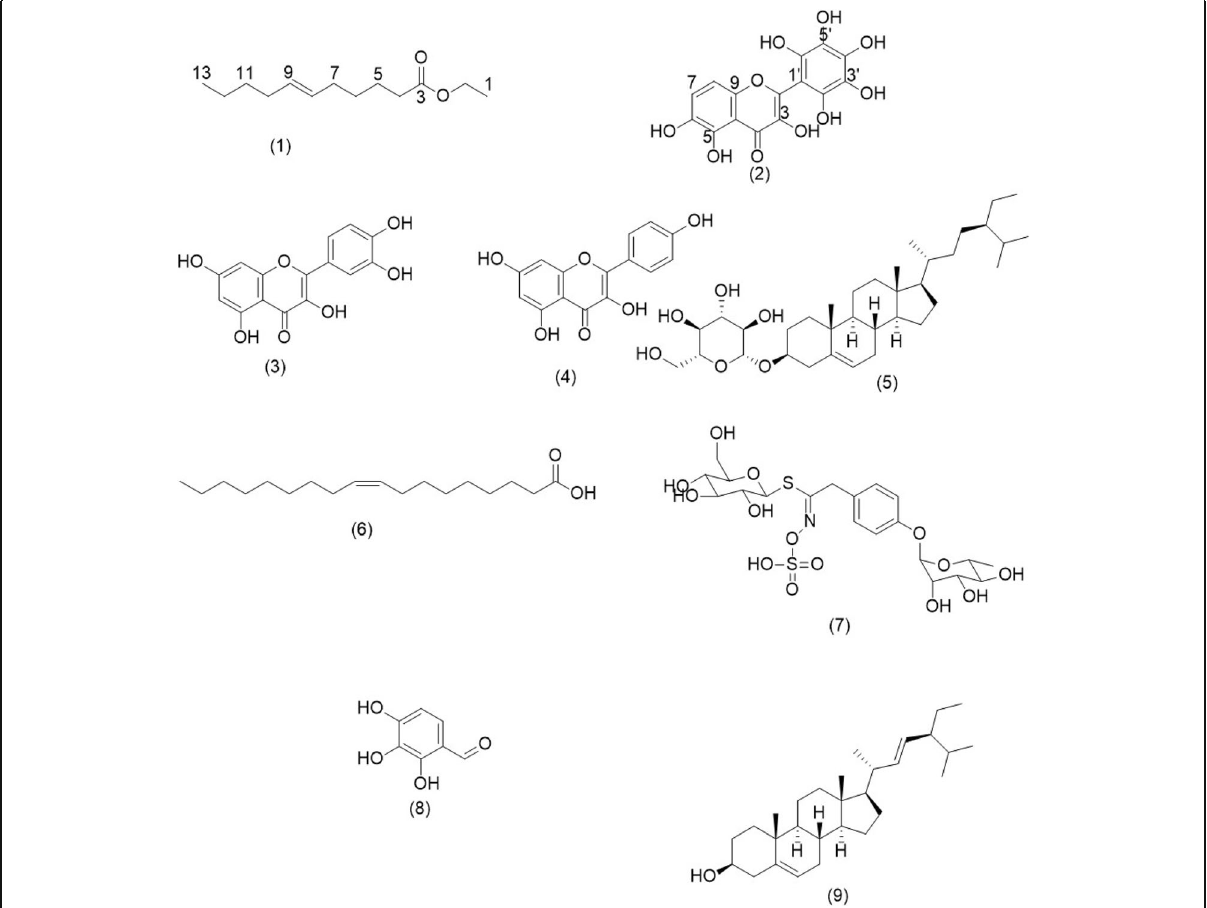
Fig. 1 Chemical structure of isolated compounds from M. oleifera . Ethyl-( E )-undec-6-enoate (1), 3,5,6-trihydroxy-2-(2,3,4,5,6-pentahydroxyphenyl)- 4 H -chromen-4-one (2), Quercetin (3), Kaempferol (4), β -sitosterol-3- O -glucoside (5), Oleic acid (6), Glucomoringin (7), Stigmasterol